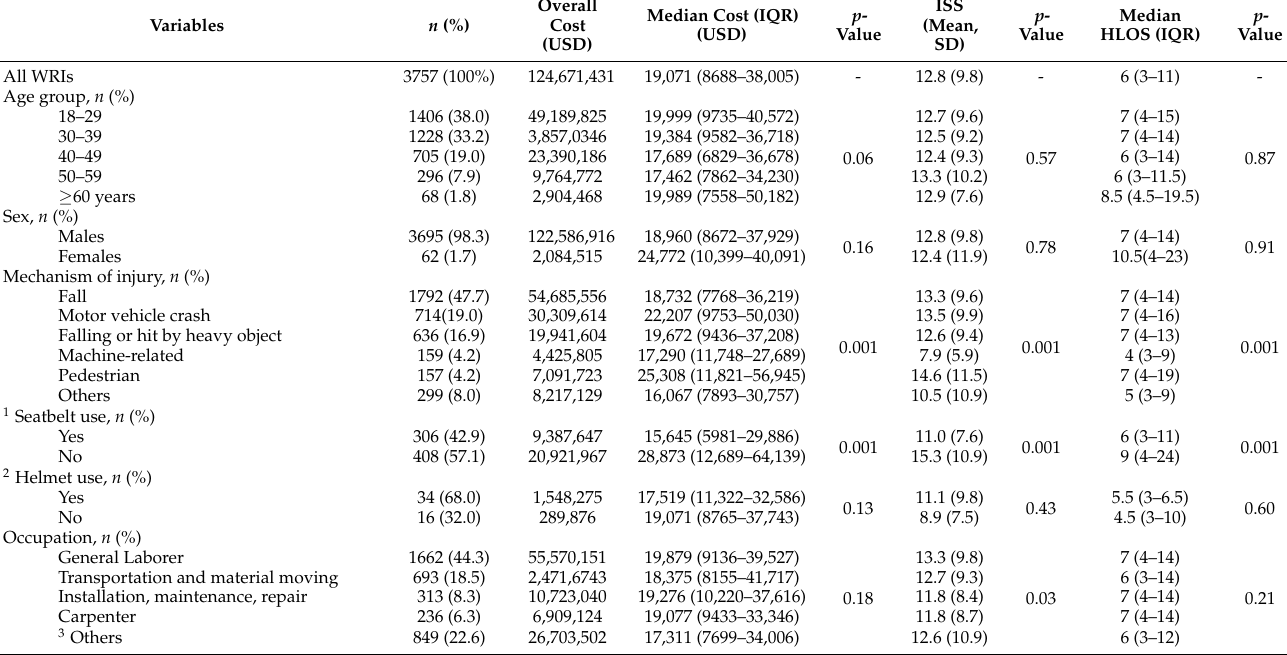
Table 1. Median costs incurred, injury severity and hospital length of stay by different patient groups with work-related injuries, Hamad Trauma Center, Qatar (2011–2017).